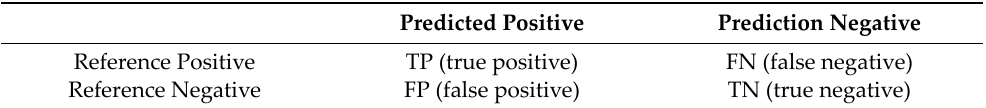
Table 4. Evaluation indicators. Predicted Positive Prediction Negative Reference